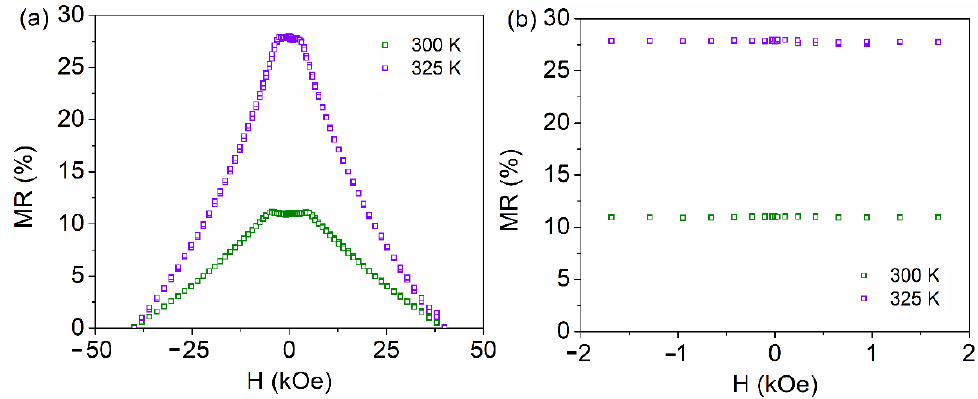
Figure 8. MR curves of LSMO 36 sample collected in perpendicular geometry ( a ). MR curves collected in perpendicular geometry in the low field region ( b ).